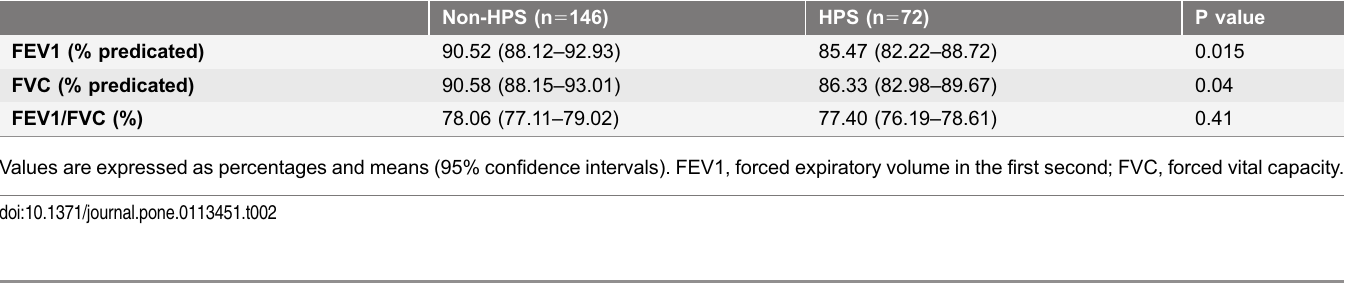
Table 2. Spirometric results in liver patients with and without